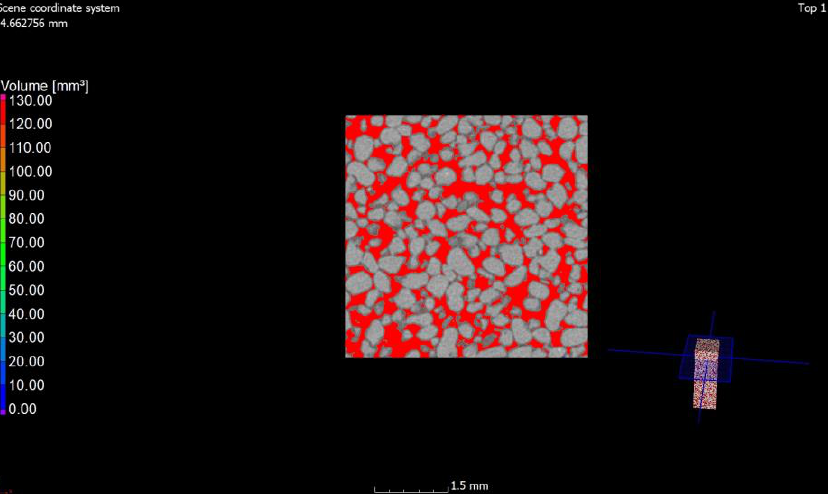
Figure 8. Cross-section through the reference material along with a photo from the scanning elec- tron microscope; image 500×. ( a ) ( b )